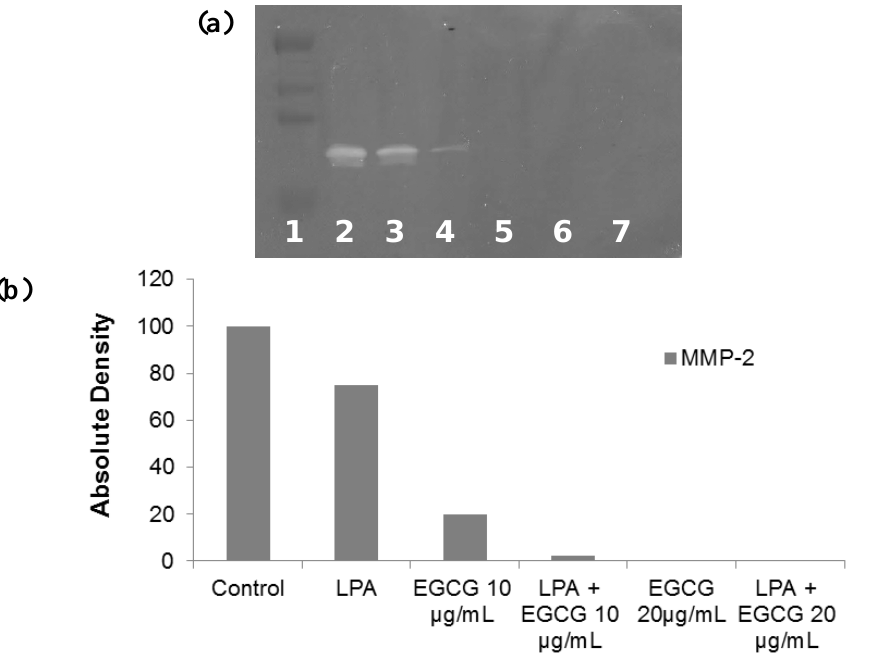
Figure 2. Comparative effect of EGCG with and without LPA on HepG2 MMP secretion. ( a ) Effect of EGCG with and without LPA on HepG2 MMP secretion: gelatinase zymogram. 1: Markers, 2: control, 3: LPA, 4: EGCG 10 µg/mL, 5: LPA + EGCG 10